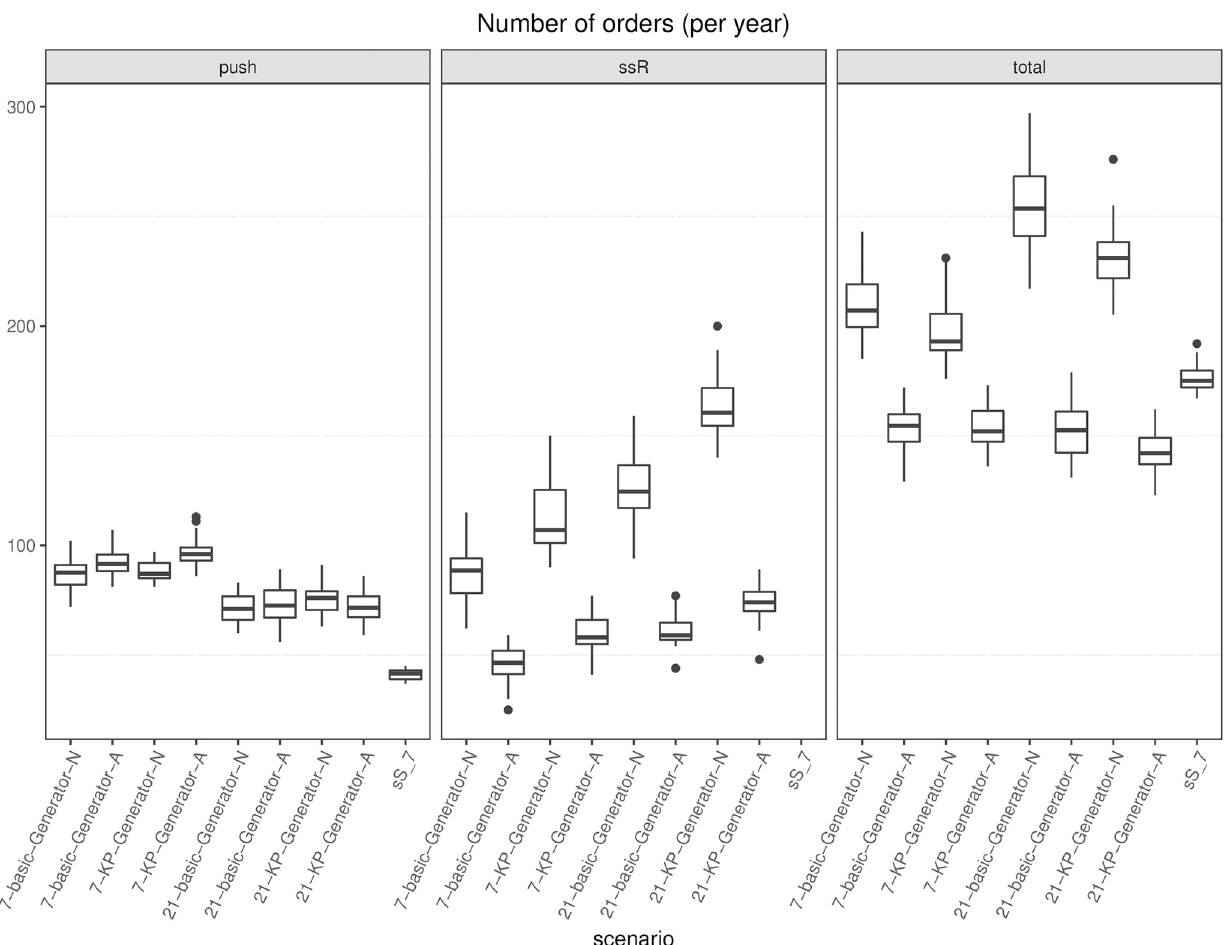
Fig 8. Boxplots of the orders (push, replenishment, all). On the left are the boxplots of the number of days with push orders per year. In the middle is the number of days with replenishment orders per year. On the right part, all orders are considered, push and pull. Each boxplot refers to 30